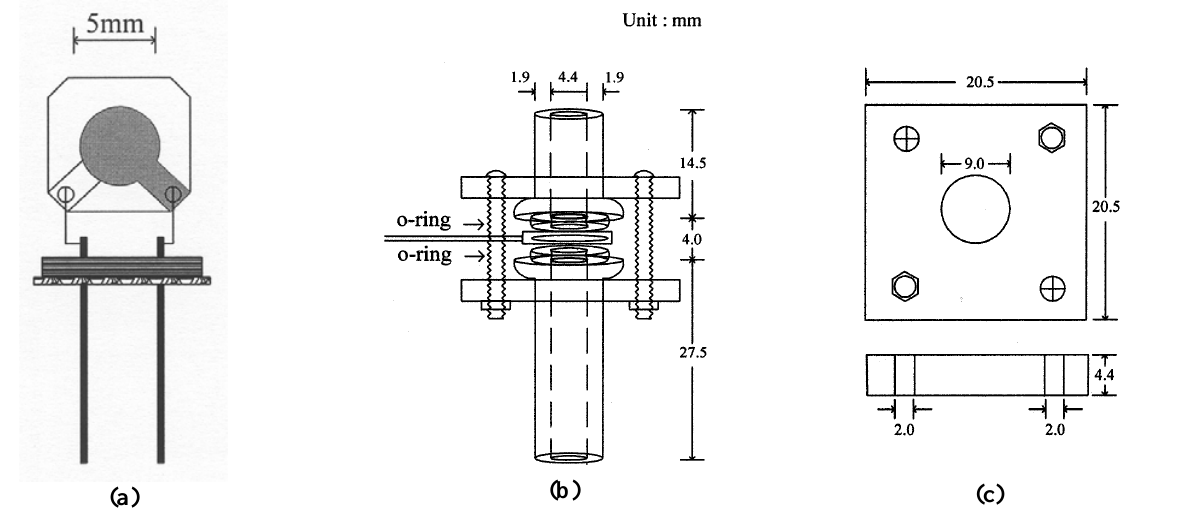
Figure 4. A schematic diagram of experimental